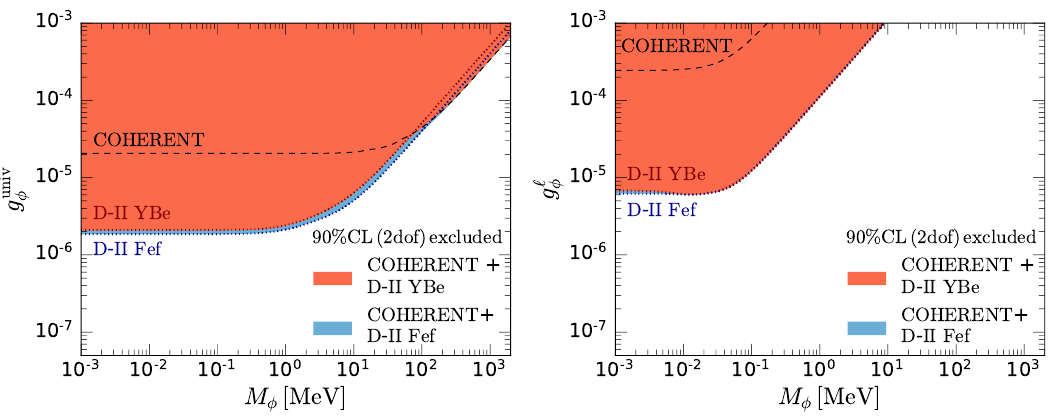
Figure 5 . Left panel: 90% CL (2 dof, two-sided, ∆ χ 2 = 4 . 61 ) excluded regions for models with light scalar mediators coupled universally to all relevant fermions. Right panel: 90% CL (2 dof, two-sided, ∆ χ 2 = 4 . 61 ) excluded regions for models with light scalar mediators coupled only to leptons. The thick blue and red dotted lines show the boundary of the region excluded by the Dresden-II reactor experiment with the Fef and YBe quenching factors, respectively. The black dashed line shows the boundary of region excluded from the analysis of COHERENT CsI and Ar data. The filled regions are those excluded by the combined COHERENT+Dresden-II